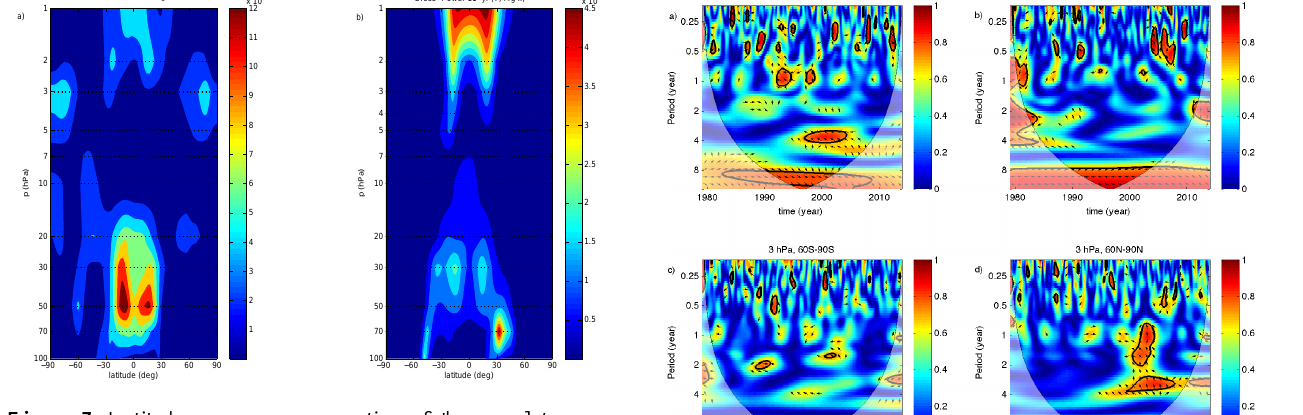
Figure 7. Latitude–pressure cross section of the wavelet cross- power spectral density (CPSD) for the 11-year period between (a) O 3 and Mg II index and (b) O 3 and T monthly standardized anomaly time series. Figure 8. Wavelet coherence for the input signals O